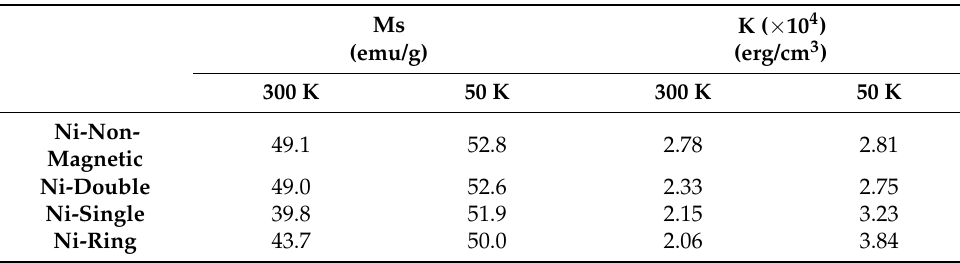
Figure 4. Room temperature magnetic hysteresis loop of Ni-Non-Magnetic, Ni-Double, Ni-Single and Ni-Ring; the inset shows hysteresis in the near H = 0 region. Table 1. Saturation magnetization (Ms), magnetocrystalline anisotropy (K) at 300 K and 50 K